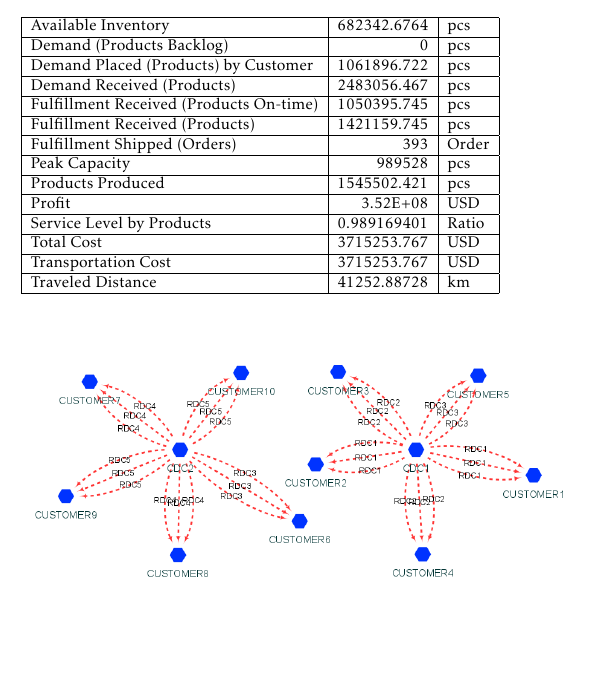
Figure 14. Several CDCs.